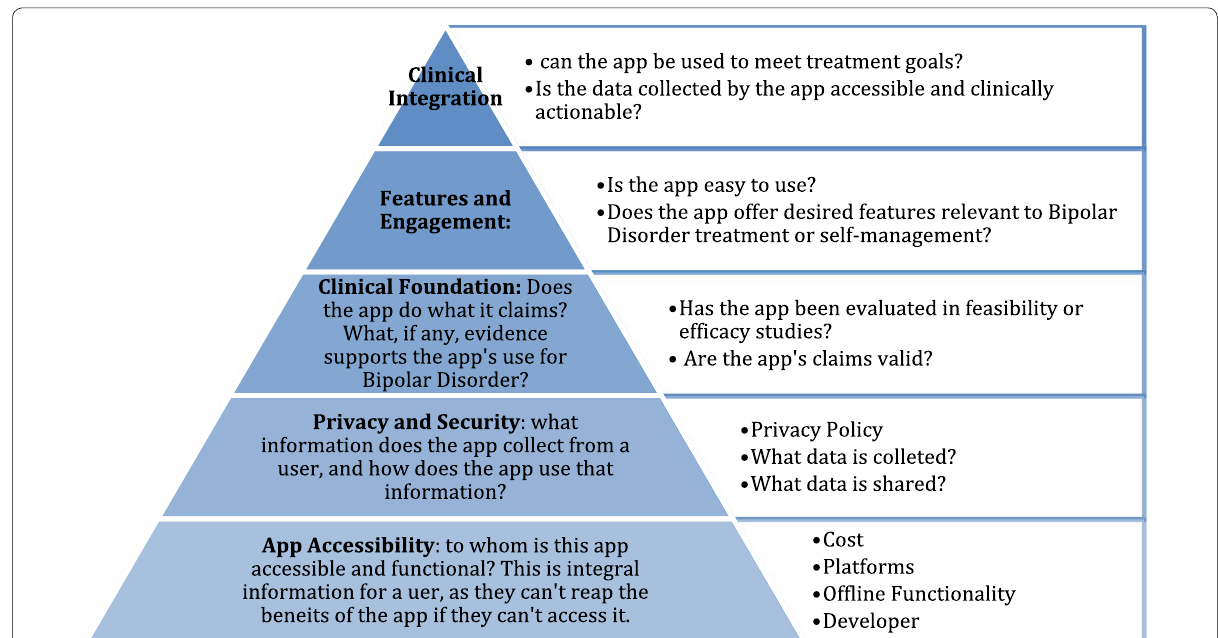
Fig. 1 Framework levels and illustrative questions. The pyramid depicts the major considerations at each level of the framework and includes illustrative questions or themes at each